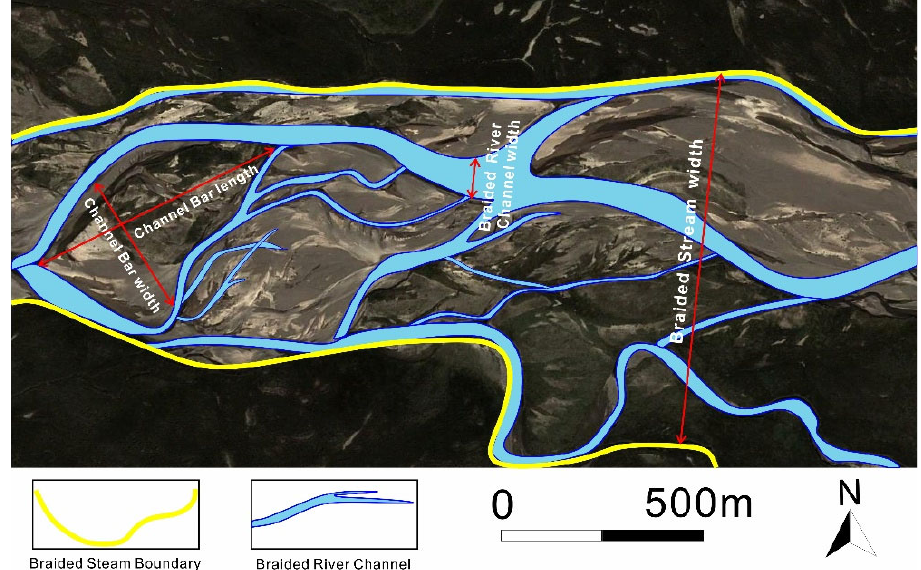
Figure 2. The measurement method of modern sedimentation.